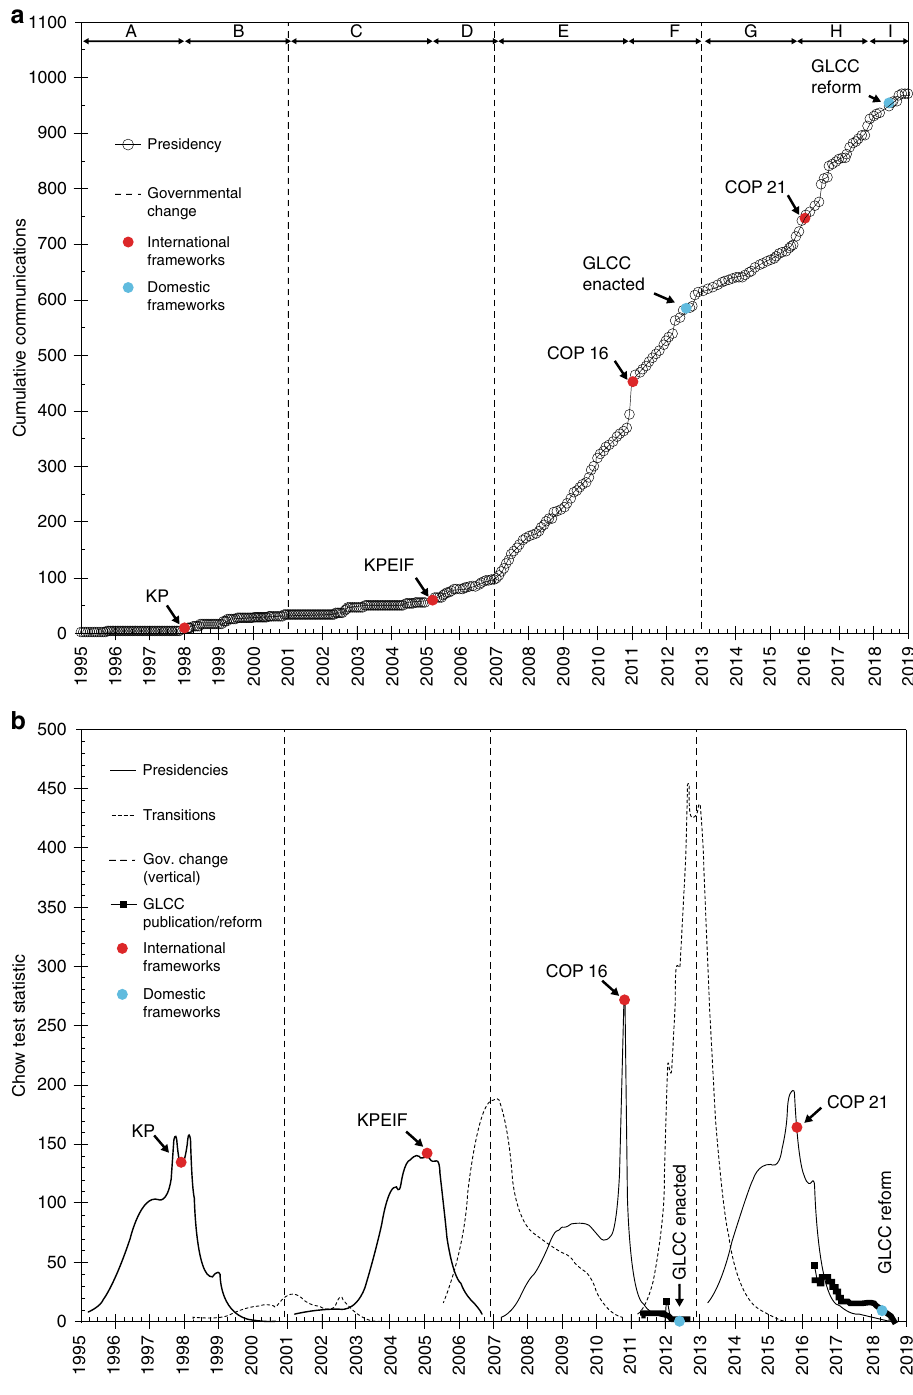
Fig. 2 Evolution of attention to climate change by Mexican presidents from 1994 to 2018 as depicted by the trends in the cumulative number of communications. Governmental changes and the dates of key developments in international and domestic frameworks are identi fi ed. a Presents the cumulative monthly communications and key events modifying the systemic and governmental agendas; the lower b Presents the Chow test statistic to test the structural differences in attention